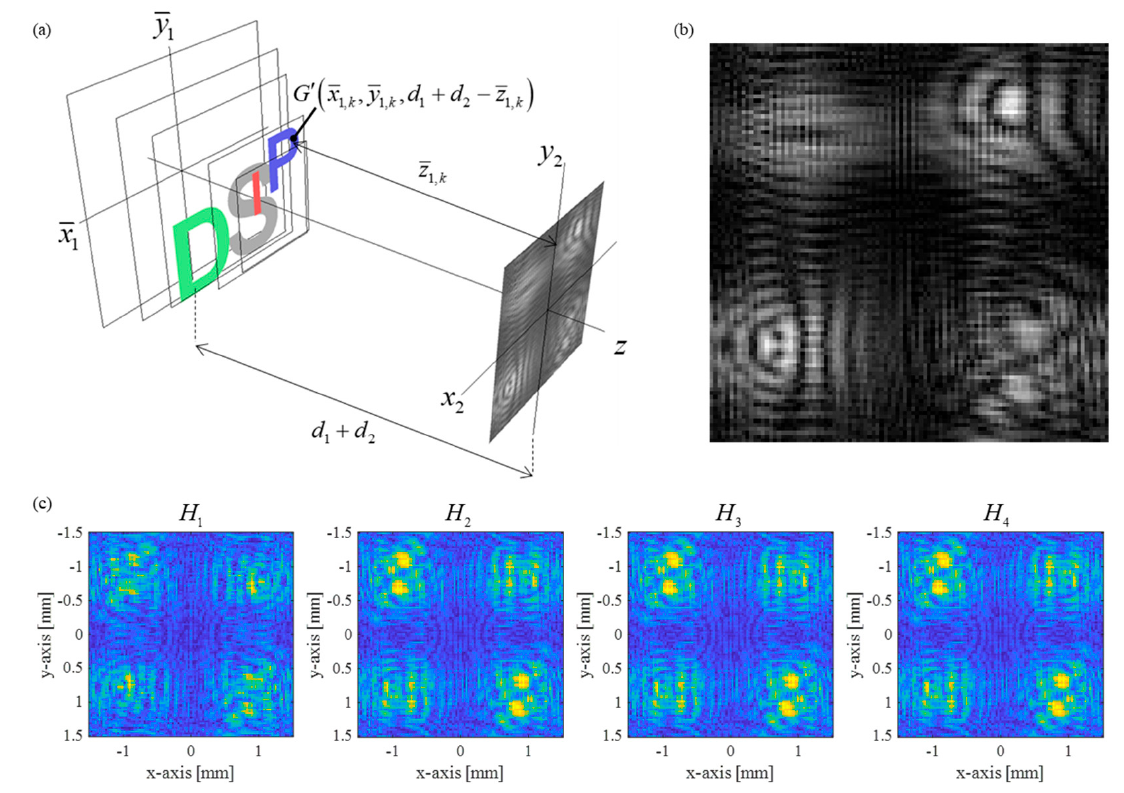
Figure 4. ( a ) The reconstruction scheme of the metalens SIDH, ( b ) the hologram pattern acquired by the metalens-based SIDH system ( d 1 = 90 mm, d 2 = 20 mm, and f = 120 mm), ( c ) four-phase shifted intensity profiles of all object points recorded on the image sensor. The image sensor is assumed to have 101 by 101 resolution, 30 µ m pixel pitch, and the operating wavelength of 550